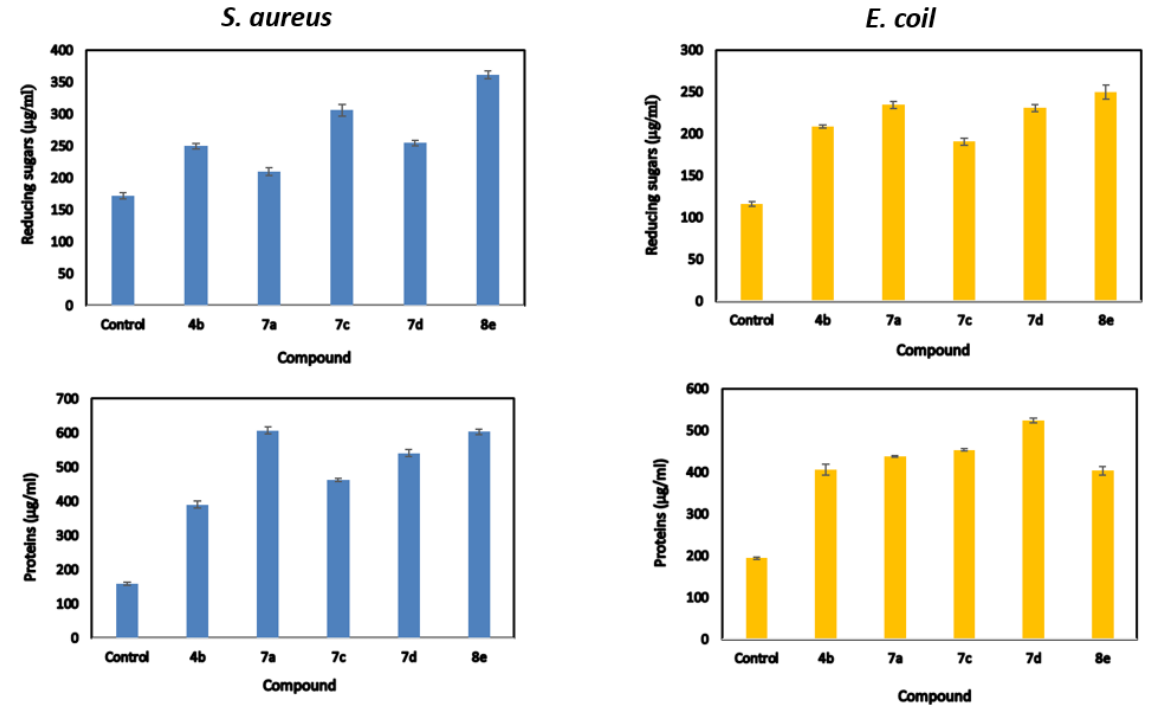
Figure 5. Reducing sugars and proteins released from treated Gram-positive ( Staphylococcus aureus ) in blue color, and Gram-negative bacteria ( Escherichia coli ) in yellow color with the most active selected compounds compared to untreated cultures (control).